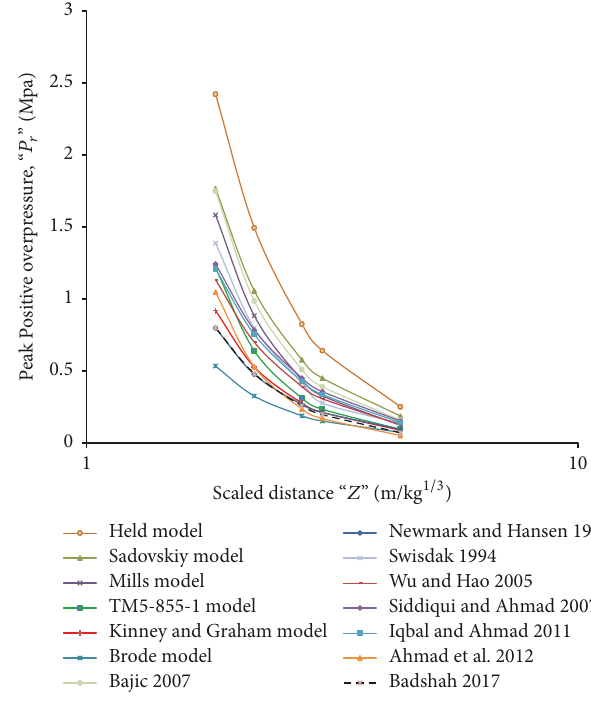
Figure 2: Comparison of blast